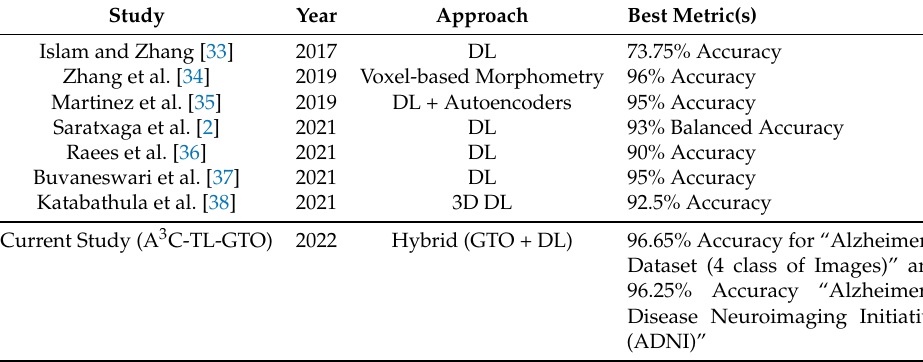
Table 9. Comparison between the suggested approach and related